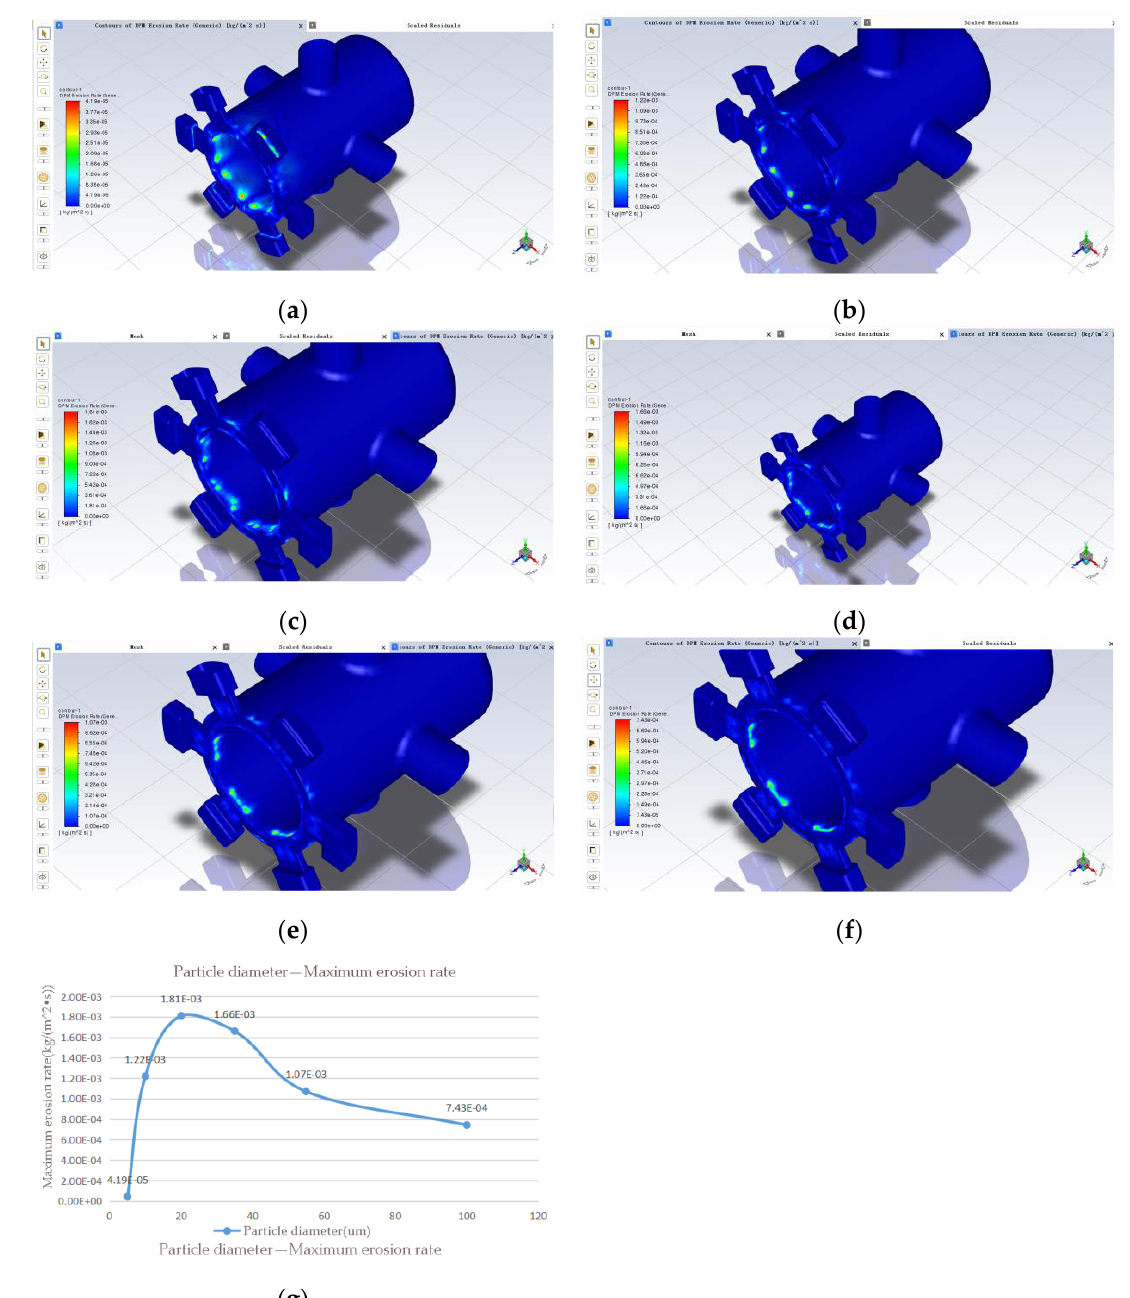
Figure 10. Effect of particle diameter on erosion rate: ( a ) 5 um; ( b ) 10 um; ( c ) 20 um; ( d ) 35 um; ( e ) 55 um; ( f ) 100 um; ( g ) variation of maximum erosion rate with increasing particle diameter.